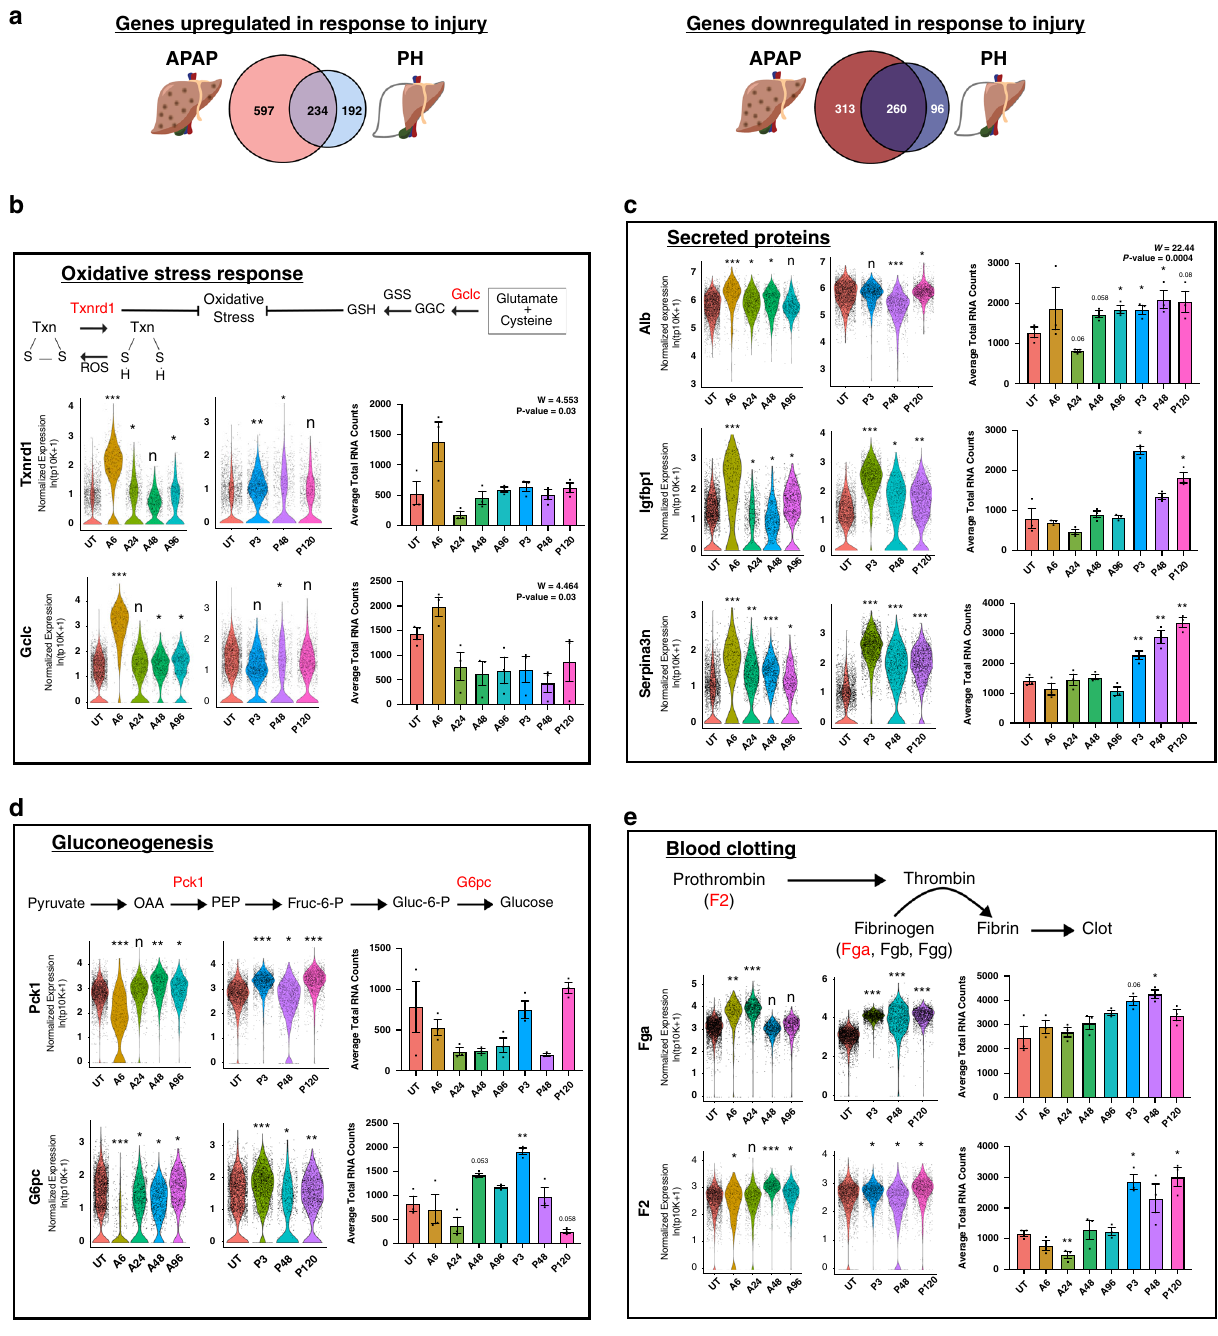
Fig. 3 Shared and unique gene expression responses in acute liver injury models. a Venn diagram showing genes signi fi cantly changed in response to APAP and/or PH treatment compared to untreated. b Expression of oxidative stress response genes ( Txnrd1 and Gclc ) signi fi cantly upregulated in APAP treatment response. c – e Expression of genes representing speci fi c hepatic functions ( c , secreted proteins; d , gluconeogenesis; e , blood clotting). scRNA- seq data (left) presented as violin plots. smFISH quanti fi cation (right) shown as bar plot with individual replicates presented as dots ( n = 3). Error bars are s.e.m., P < 0.05 (*), < 0.005 (**), < 0.0005 (***), and < 0.0001 (****) calculated using unpaired t tests with Welch ’ s correction (two-tailed) comparing untreated group (UT) to all other experimental groups. Source data provided as a Source Data fi resulted in a down-regulation of hepatic function genes at baseline complete loss of transcriptional compensation following PH. consistent with the role of Wnt signaling in hepatic function 33,39,40 Proliferative capacity was modestly decreased, yet overall main- tained (Fig. 5d, e and Supplementary Fig. 14) 41 . Resident hepatic (Fig. 5d, e). Importantly, EC- Wls -KO mice can still transcription- macrophage numbers and geographic distribution were similar (Fig. 5d, e and Supplementary Fig. 14c) 18 . In contrast, loss of Wnt between groups (Supplementary Fig. 14b). In addition, combined IF and smFISH staining revealed increased Glul transcript level processing in macrophages of Mac- Wls -KO mice resulted in within ~30 μ m (average diameter of a single hepatocyte) of F4/80 + down-regulation of all examined hepatocyte genes after injury with